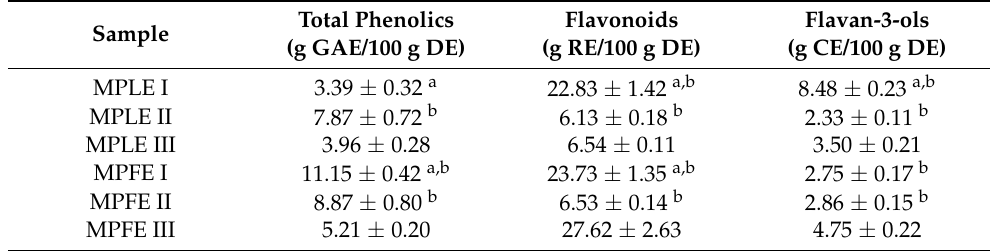
Table 2. Phytochemical screening by colorimetric assays. Results, which are reported as the mean ± standard deviation of nine independent experiments in triplicate ( n = 3), are expressed as g of gallic acid equivalents (GAE)/100 g of dry extract (DE), g of rutin equivalents (RE)/100 g DE and g of catechin equivalents (CE)/100 g DE for total phenolics, flavonoids and flavan-3-ols, respectively. Total Phenolics Flavonoids Flavan-3-ols Sample (g GAE/100 g DE) (g RE/100 g DE) (g CE/100 g DE) MPLE